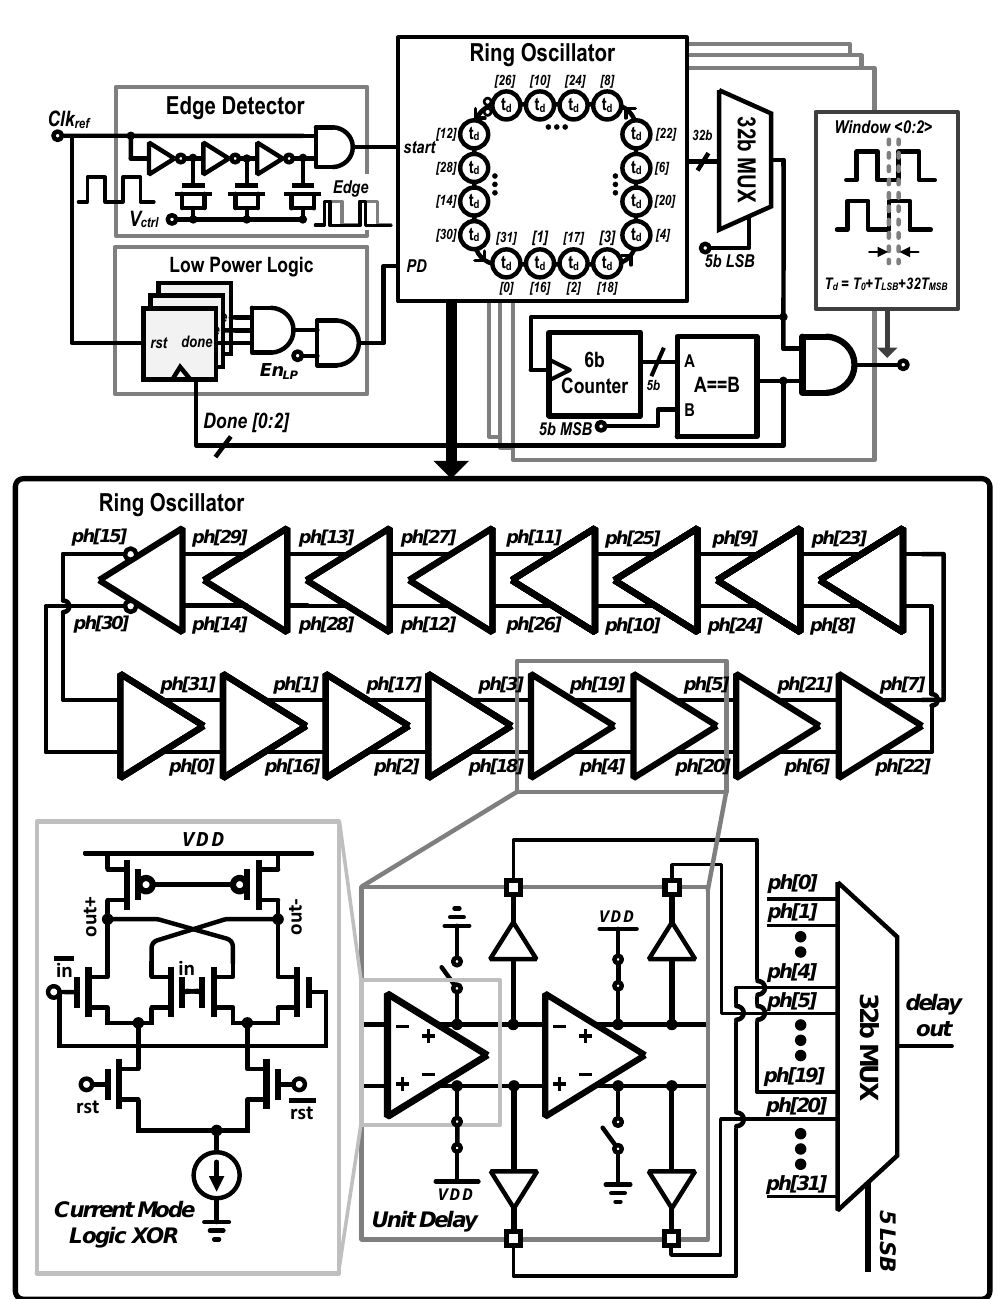
Figure 7. Schematic of high dynamic range, area efficient DTC, where ph[0:31] are nodes between each delay unit, the supply voltage VDD is 1.8 V, rst denotes reset signal to stop the ring oscillator (RO), Done[0:2] is a digital bit to power gate the RO to enable the low power DTC